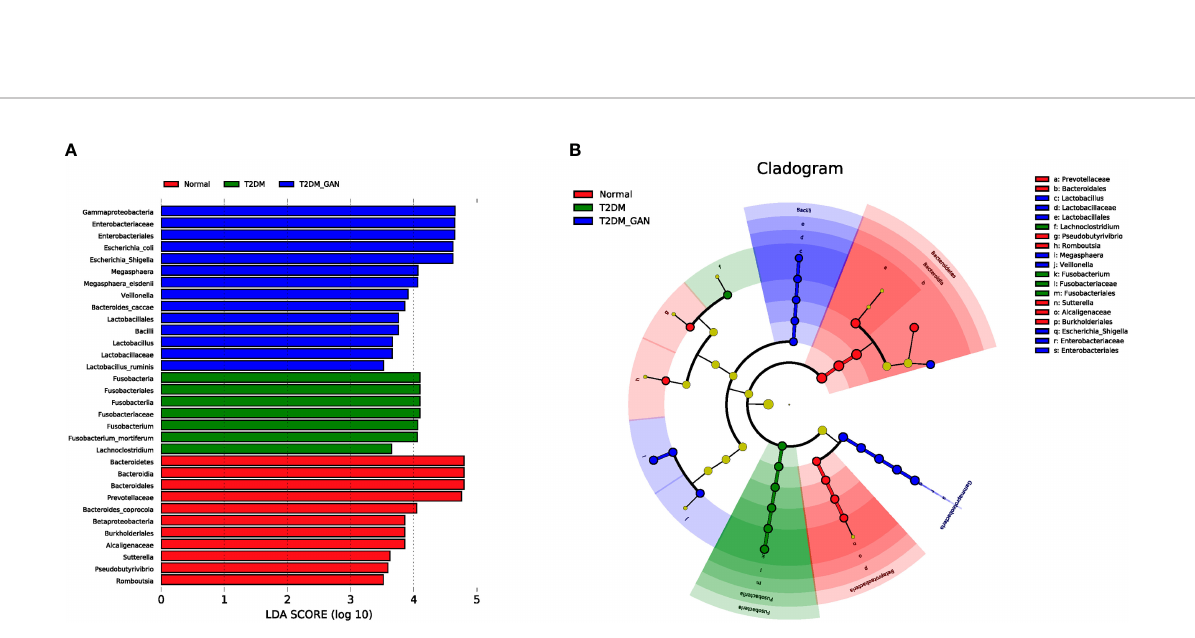
FIGURE 4 | The biomarkers characteristic of the gut microbiota among the subjects. (A) Histogram of LDA scores: the height of the column represents the size of the LDA score, and the higher this value, the more signi fi cant the impact on the fi nal classi fi cation (LDA > 3.5). (B) Cladogram showing differentially abundant taxonomic clades with an LDA score